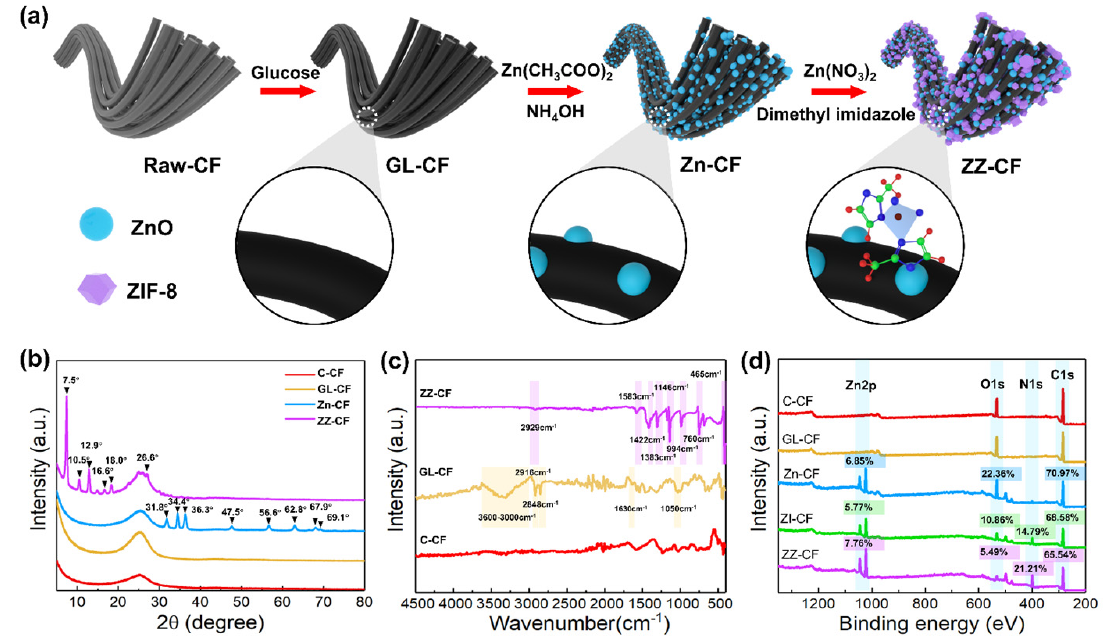
Figure 1. ( a ) Schematic diagram of the designed process for ZZ–CF photocatalysts; ( b ) XRD pattern of C–CF, GL–CF, Zn–CF, and ZZ–CF, respectively; ( c ) FTIR spectrum of R–CF, GL–CF, and